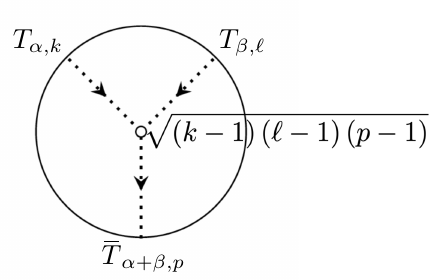
enforcing charge k + ‘ − p, 0